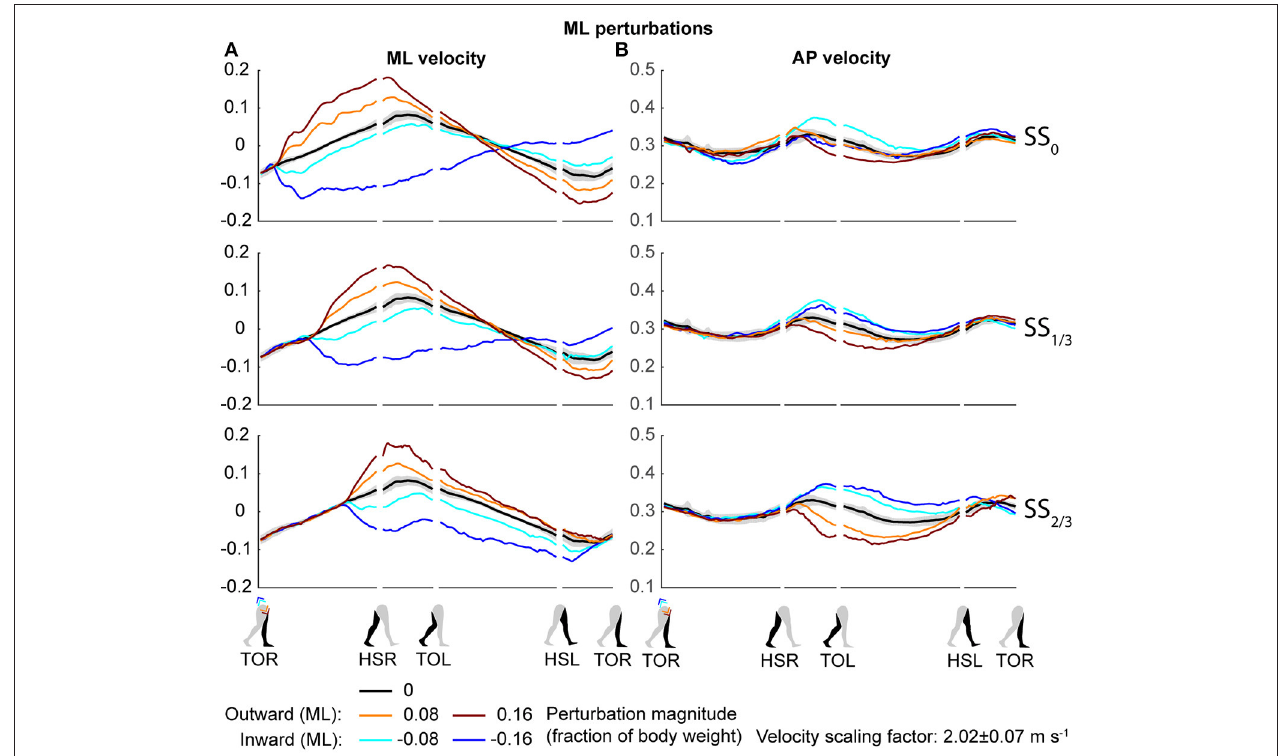
FIGURE 2 | COM velocity profiles following ML perturbation. (A) ML COM velocity in response to ML perturbations. (B) AP COM velocity in response to ML perturbations. Top, middle, and bottom rows correspond with perturbation onset instances of SS 0 , SS 1 / 3 , and SS 2 / 3 , respectively. Data is shown as a function of the gait phase. Colors indicate the various perturbation magnitudes. Shaded areas indicates the subject-standard deviation for the unperturbed condition. It is not shown for perturbed conditions to prevent image cluttering. Data is shown dimensionless.